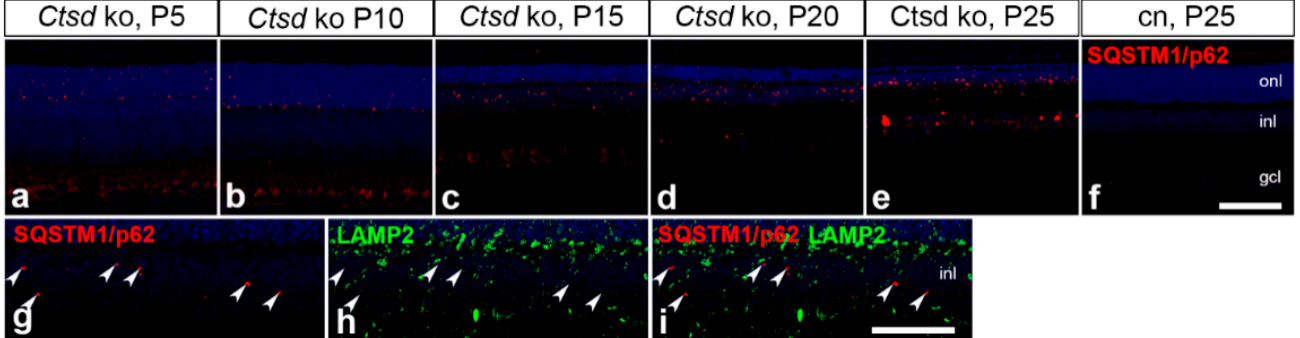
Figure 5. Expression of SQSTM1/p62 in Ctsd ko retinas. SQSTM1/p62-immunoreactive punctae in P5 ( a ) and P10 Ctsd ko retinas ( b ) were mainly restricted to the outer nuclear layer. In 15- ( c ), 20- ( d ) and 25- ( e ) day-old mutants, in comparison, expression of the autophagy marker was mainly confined to the inner nuclear layer. SQSTM1/p62-positive punctae were not detectable in retinas from control mice (for a P25 retina, see ( f )). SQSTM1/p62 ( g ) and LAMP2 ( h ) showed hardly any co-localization (white arrowheads in g – i ) in P15 Ctsd ko retinas. cn, control; gcl, ganglion cell layer; inl, inner nuclear layer; ko, knock-out; LAMP2, lysosomal-associated membrane protein 2; onl, outer nuclear layer; P, postnatal day; SQSTM1/p62, sequestosome 1/p62. Scale bar in ( f ): 100 µm; in ( i ): 50 µm.